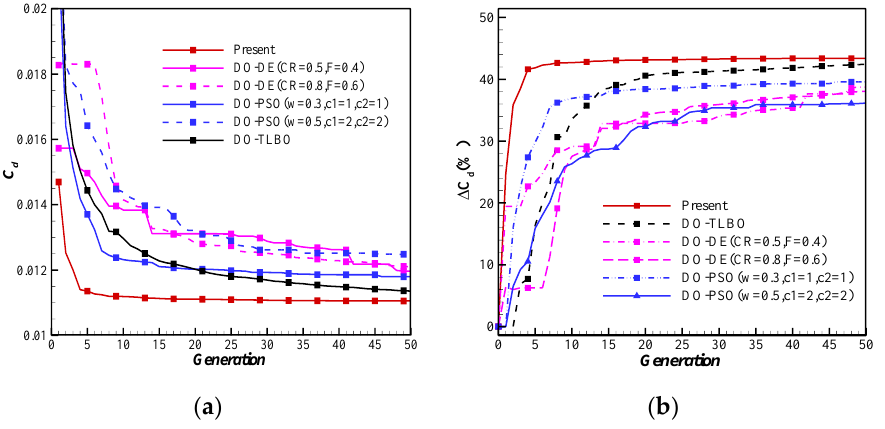
Figure 5. Convergence process and reduction of drag coefficient (C d ) with the generation process by different ASO methods. ( a ) Average convergence process of C d ; ( b ) Reduction of C d .